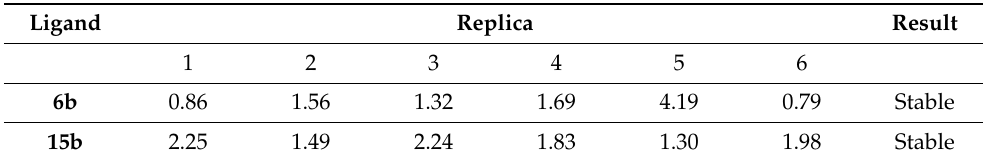
Table 5. Stability of binding mode 1 of both investigated ligands, expressed as RMSD (Å) 1 to the docking